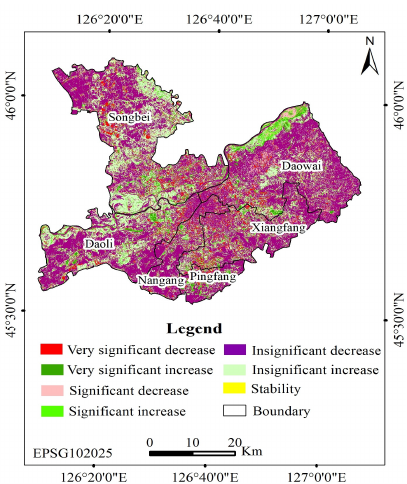
Figure 7. The average values ( a ) and coe ffi cient of variations ( b ) for vegetation coverage in Harbin from 2004 to 2020.